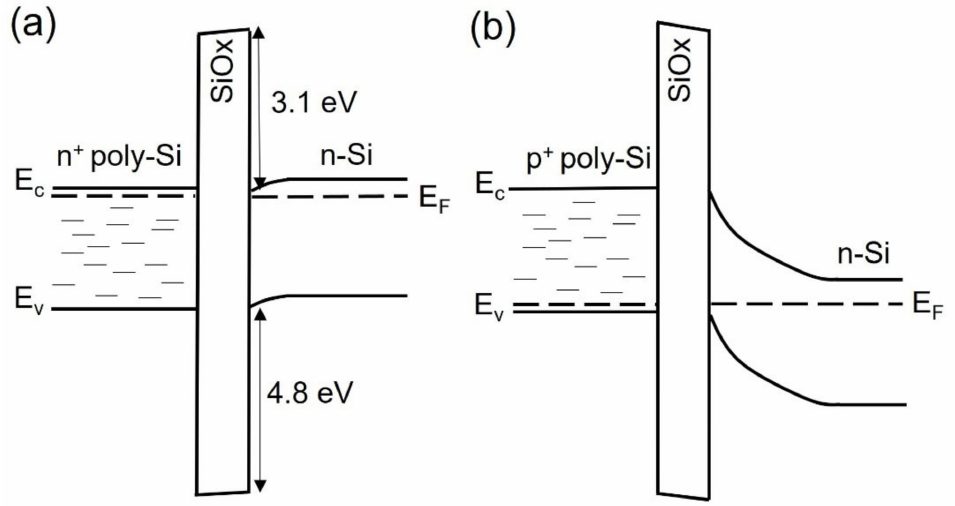
Figure 6. Schematic energy band diagram of ( a ) n + polysilicon/n-Si POLO contact; ( b ) p + polysilicon/n-Si POLO